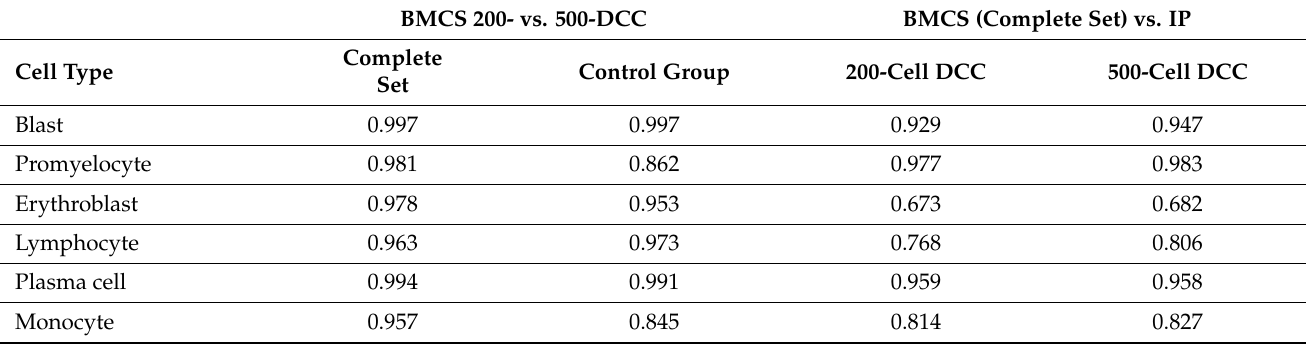
Table 4. Comparison analysis between BMCS 200-cell versus 500-cell DCC and between BMCS and IP according to main types of cells *.